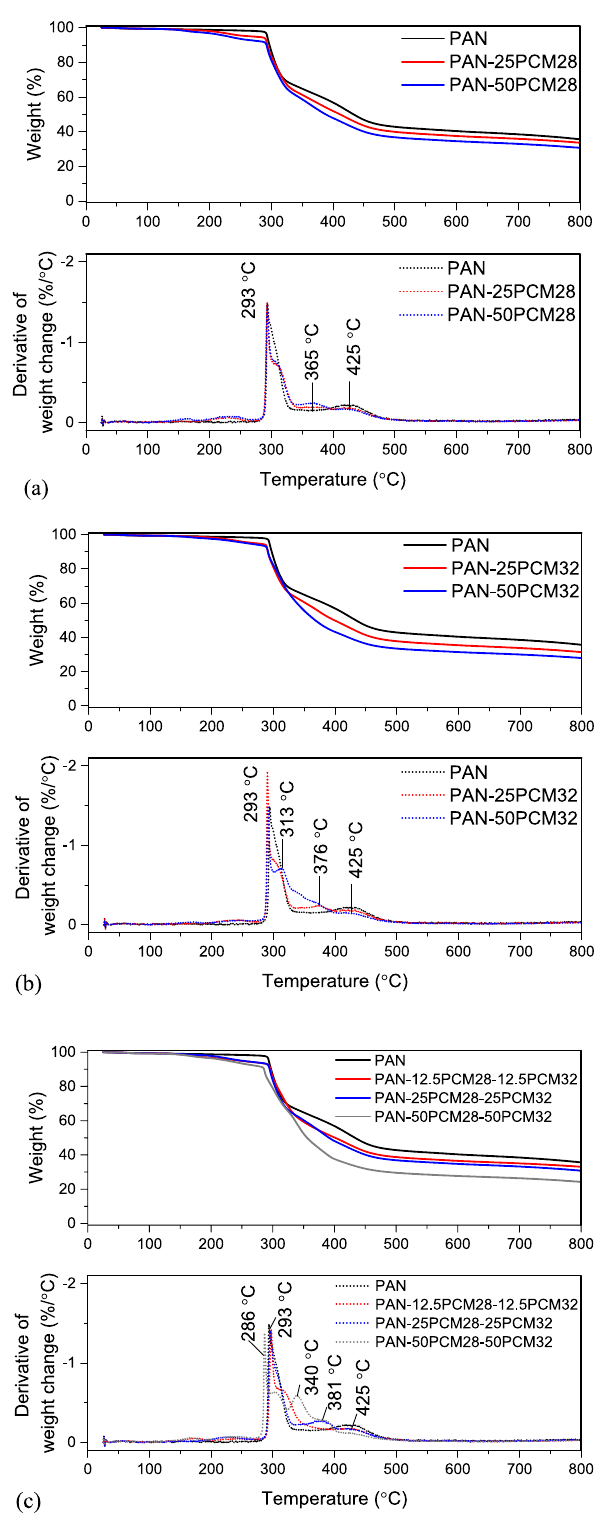
Figure 11. Thermal decomposition behaviours of composite PAN/PCM nanofiber mats in comparison to neat PAN nanofiber